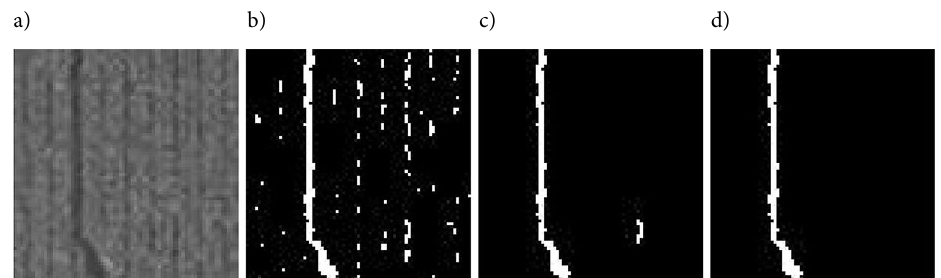
Figure 5. Example of continuous pavement crack: a – raw crack block; b – local filtering; c – minor removal; d – maximum extraction